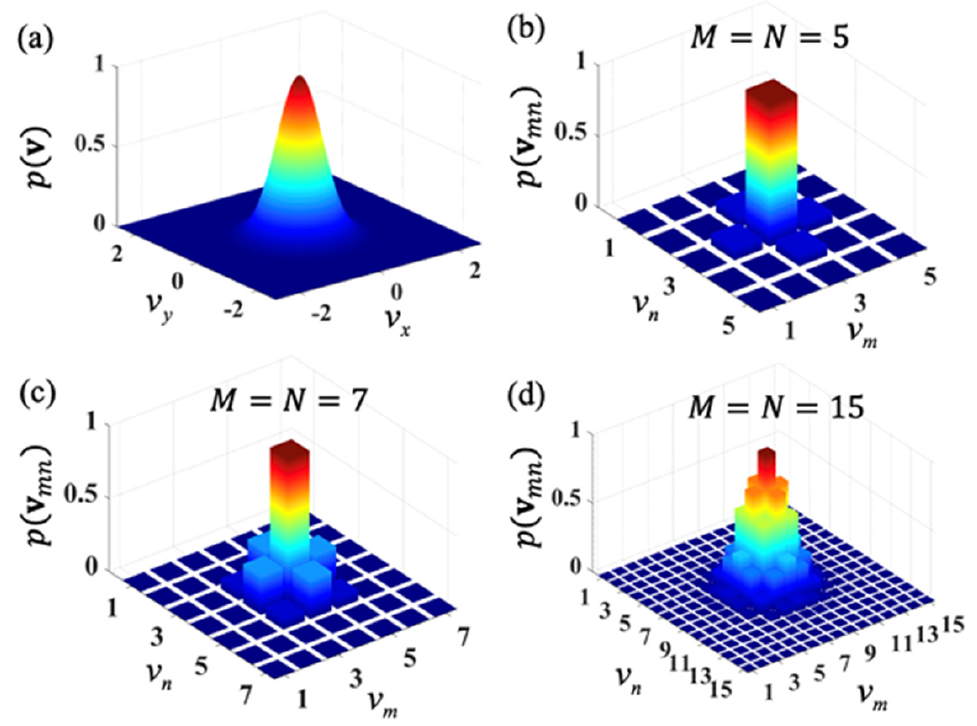
Figure 1. ( a ) The spatial distribution of the weight function 𝑝(v) . ( b – d ) The variation of the discrete ) with indices 𝑚 and 𝑛 when the total number of the discrete modes is selected as function 𝑝(v (cid:3040)(cid:3041) ( b ) 𝑀 = 𝑁 = 5 , ( c ) 𝑀 = 𝑁 = 7 , and ( d ) 𝑀 = 𝑁 = 15